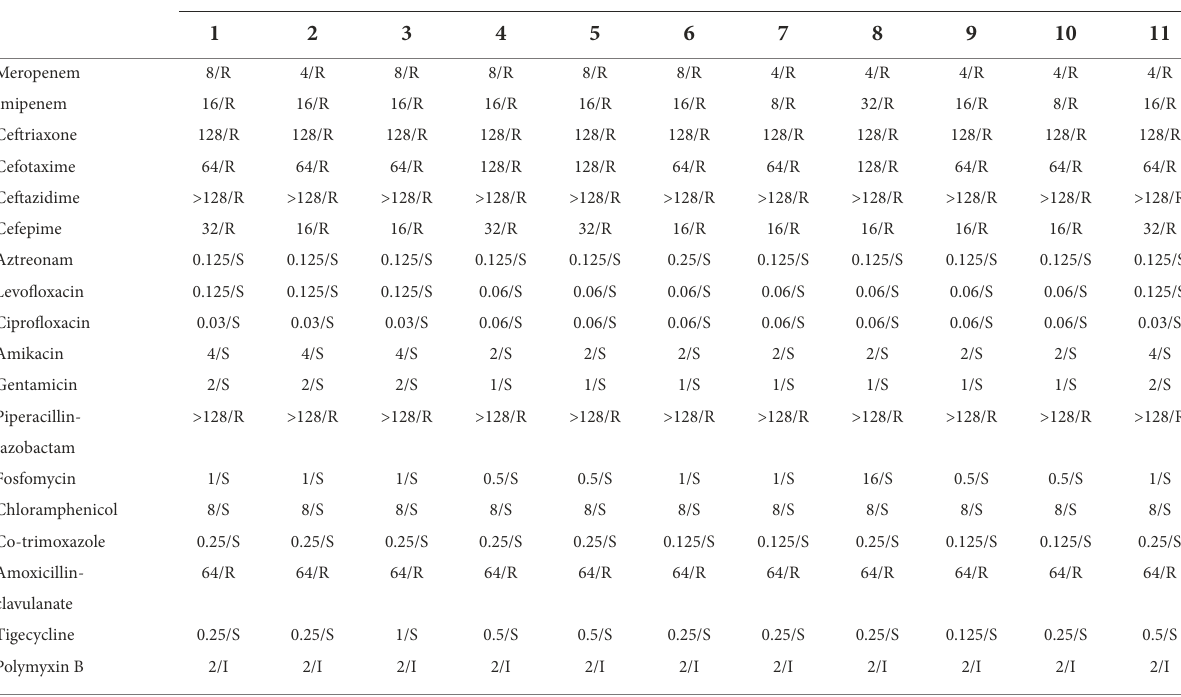
TABLE 2 MICs of 11 K. pneumoniae strains isolated from mouse feces of DY1928 group.